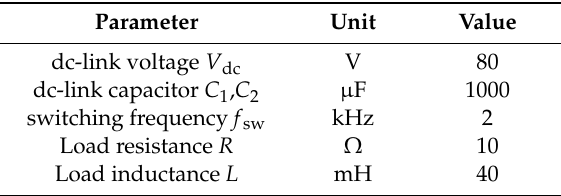
Figure 6. The experimental prototype of the neutral-point-clamped three-level inverter: ( a ) the overall experimental prototype; ( b ) the main components of the NPC three-level inverter. Table 7. Parameters of the experimental prototype.